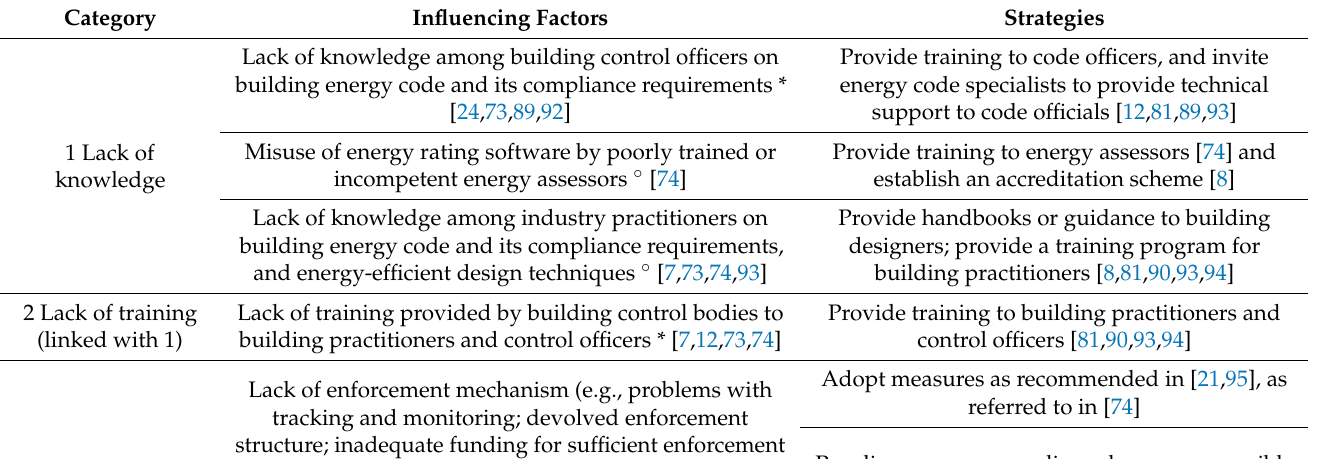
Table 1. Influencing factors for non-compliance and corresponding strategies to